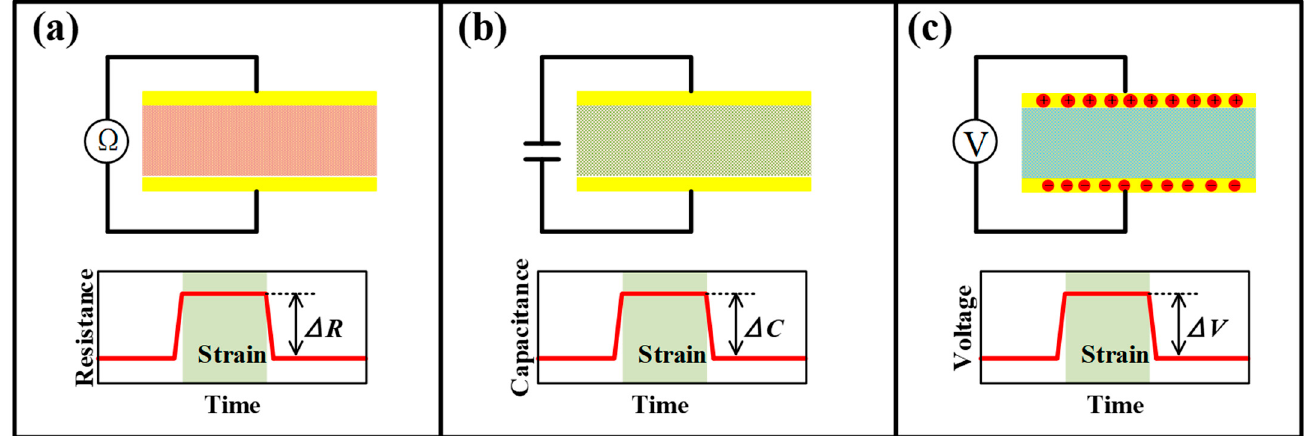
Figure 4. The illustration of mechanisms of ( a ) piezoresistive, ( b ) capacitive and ( c ) piezoelectric strain sensors.